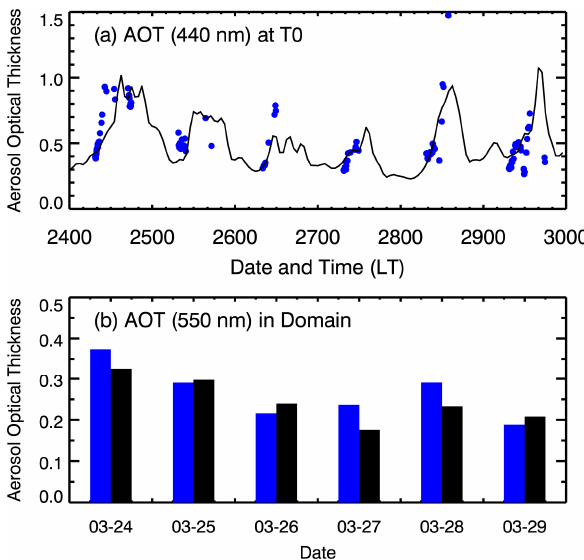
Fig. 5. (a) Diurnal variations of measured (blue dots) and simulated (black line) aerosol optical thickness at T0 and (b) daily and domain averaged MODIS measured (blue) and calculated (black) aerosol optical thickness during the period from 24 to 29 March 2006. See Fig. 2 for the x-axis labels in (a) . The x-axis labels (named date) in (b) represent month and day (MM-DD). For example, 03–24 repre- sents 24 March.